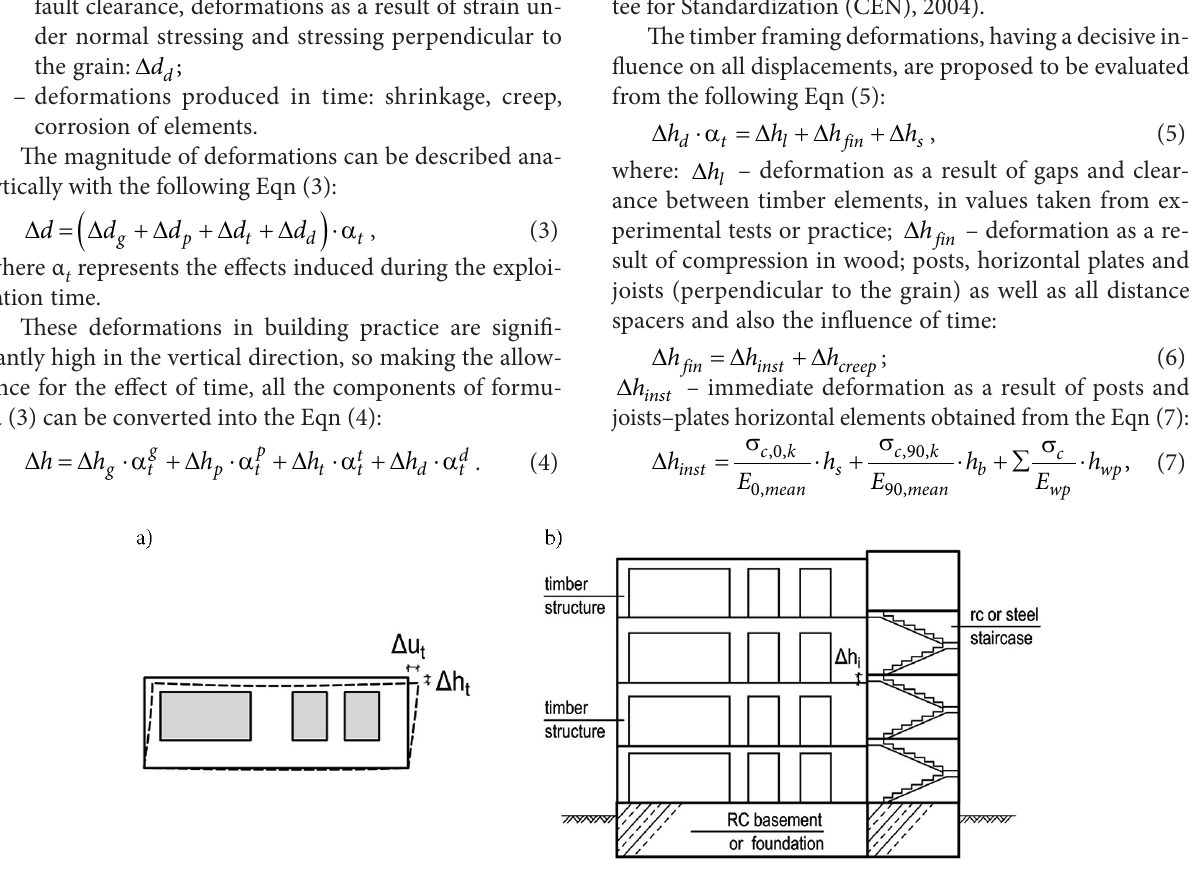
Figure 7. Transport deformation: a – of module; b – in